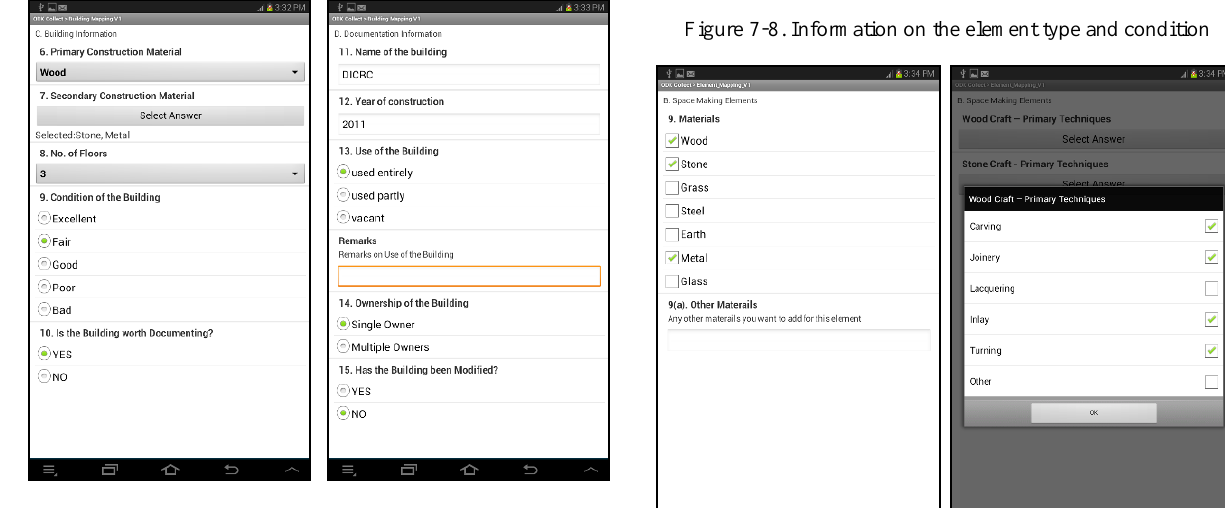
Figure 5-6. Excerpts from Building Mapping Form